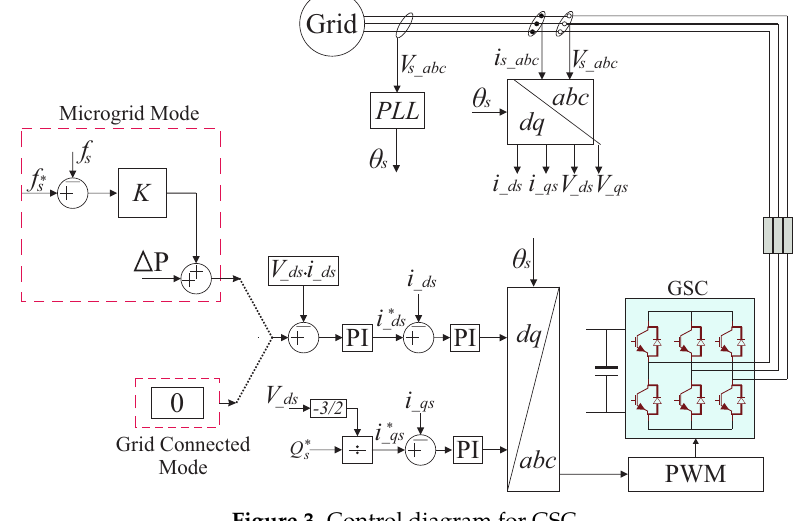
Figure 3. Control diagram for